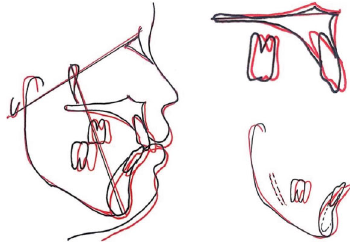
Figure 9: Superimpositions of pre- and posttreatment cephalograms.